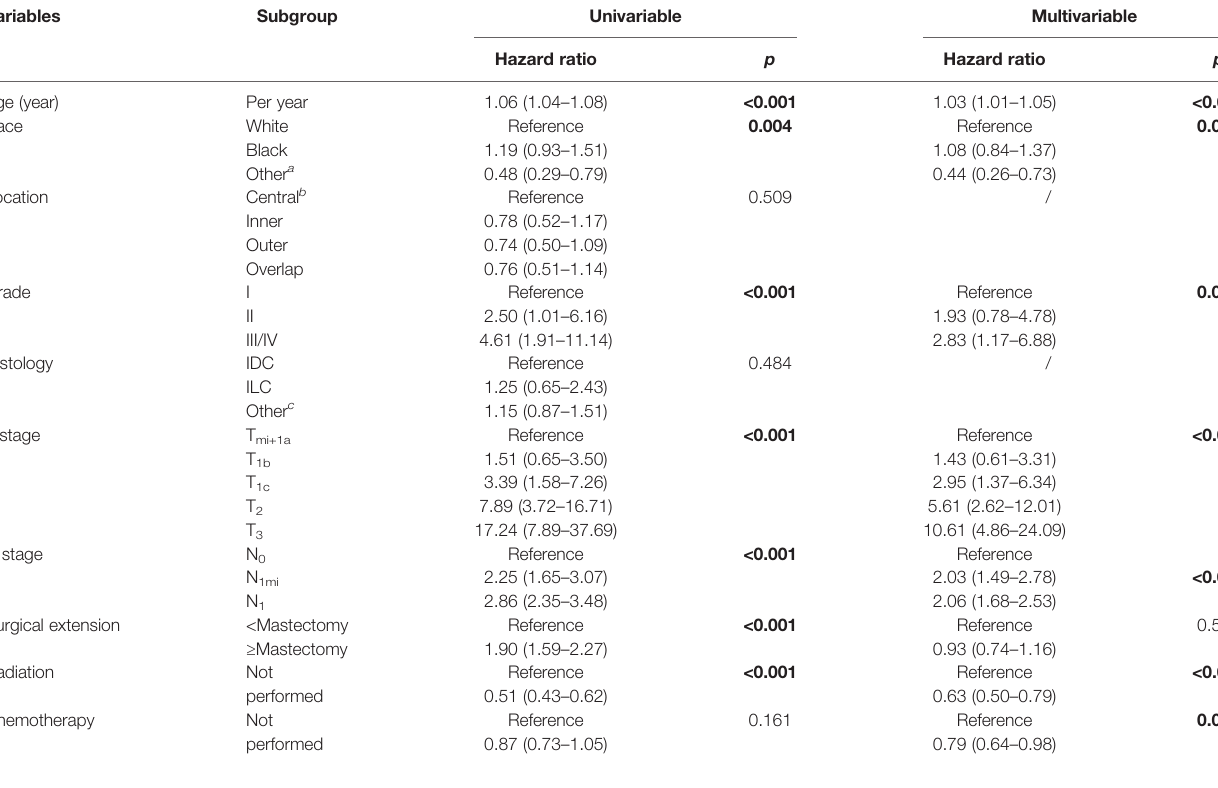
TABLE 3 | Univariate and multivariate Cox regression analyses of predictive variables correlated with CSS in elderly primary operable TNBC patients ( ≥ 70 years